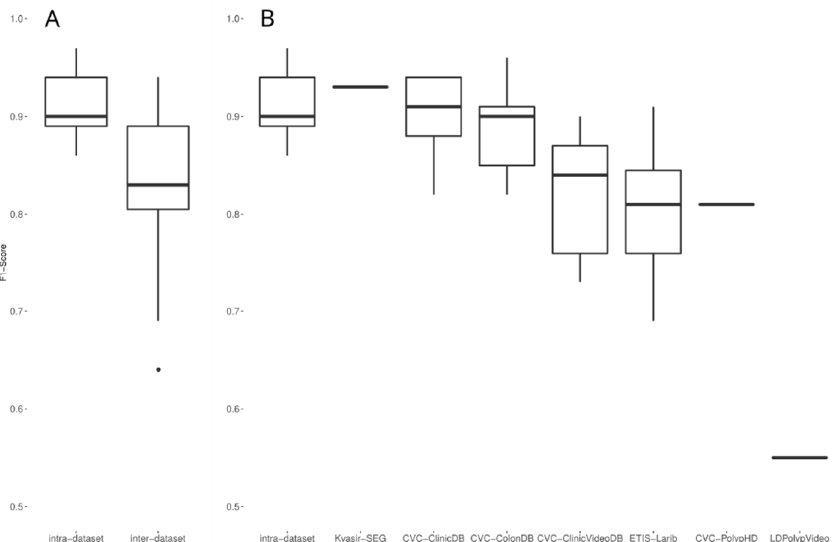
Figure 7. Comparison of F1-score decay on public colonoscopy image datasets of those studies reporting their performance for the private test set partition.